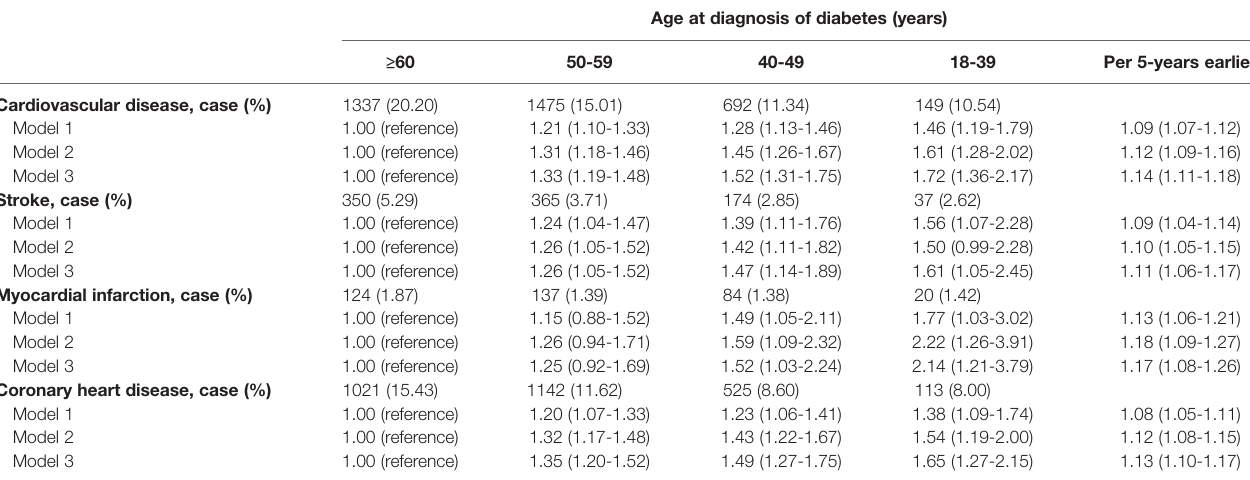
TABLE 2 | Odds ratio (95% CI) for cardiovascular disease risks according to age at diagnosis of diabetes.